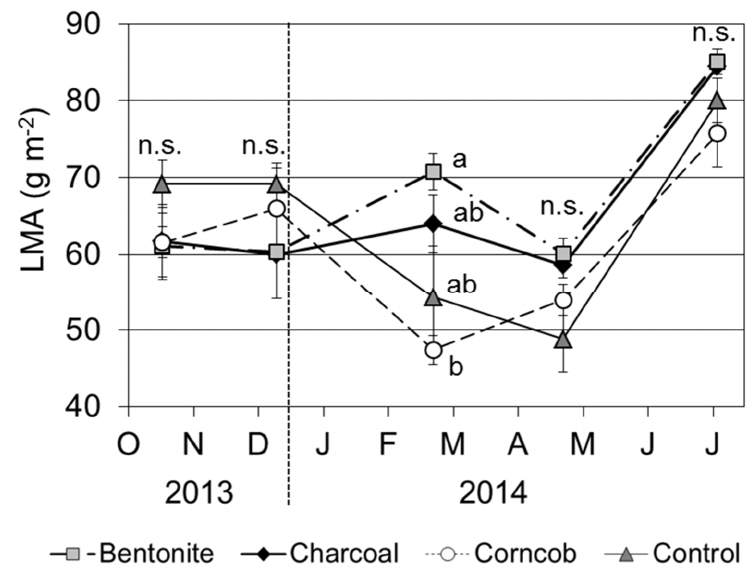
Figure 9. Leaf mass per area (LMA) for teak seedlings grown in the four treatments (Mean ± SE, n = 4).